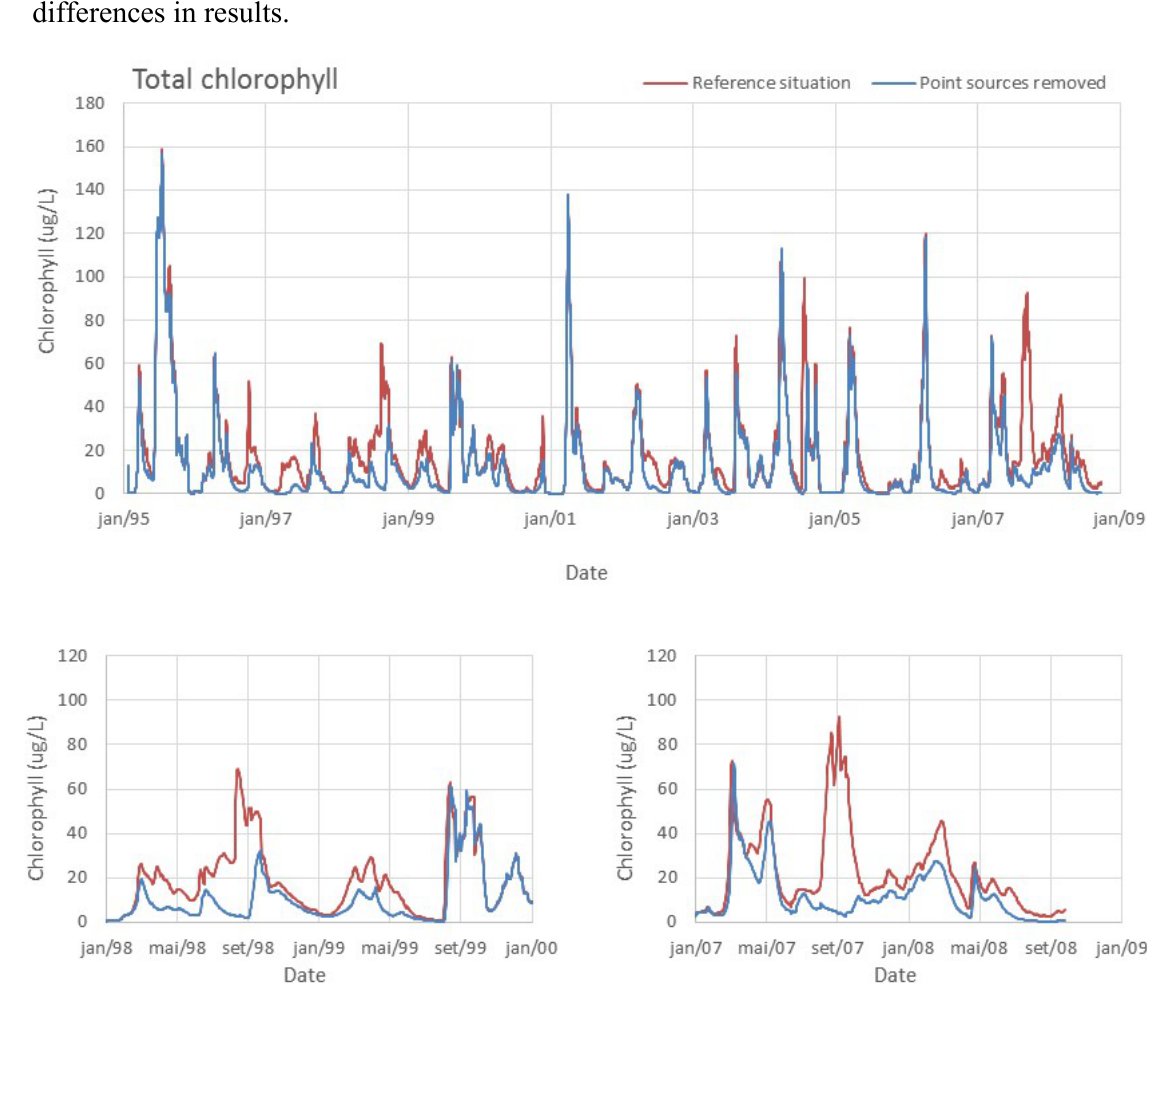
Figure 7. Model results for the reference situation and for the scenario where the point sources of nutrients have been removed. Lower panels show smaller periods to highlight differences in